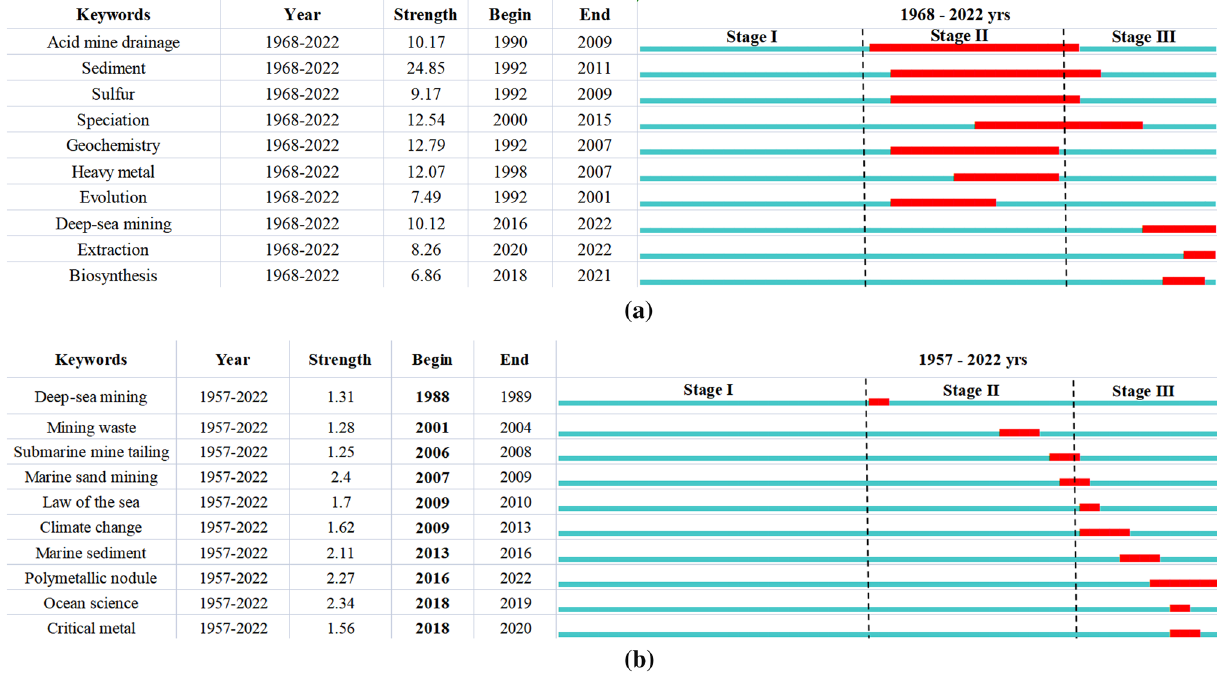
Fig. 6 Top 10 hotspots in the literature on ocean mineral resources during different time periods a WOS database and b CNKI